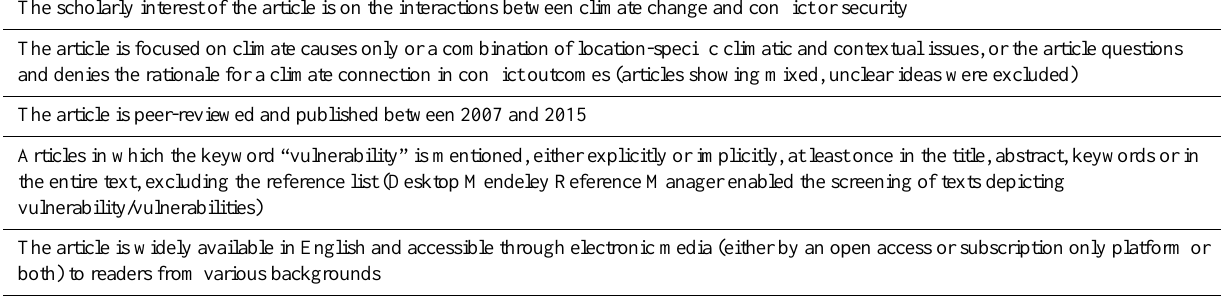
Table 4. Article selection